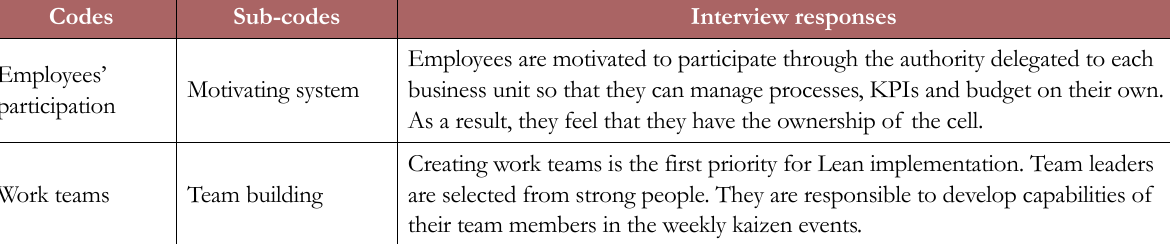
Table 2. Quotes of interviews related to dimension